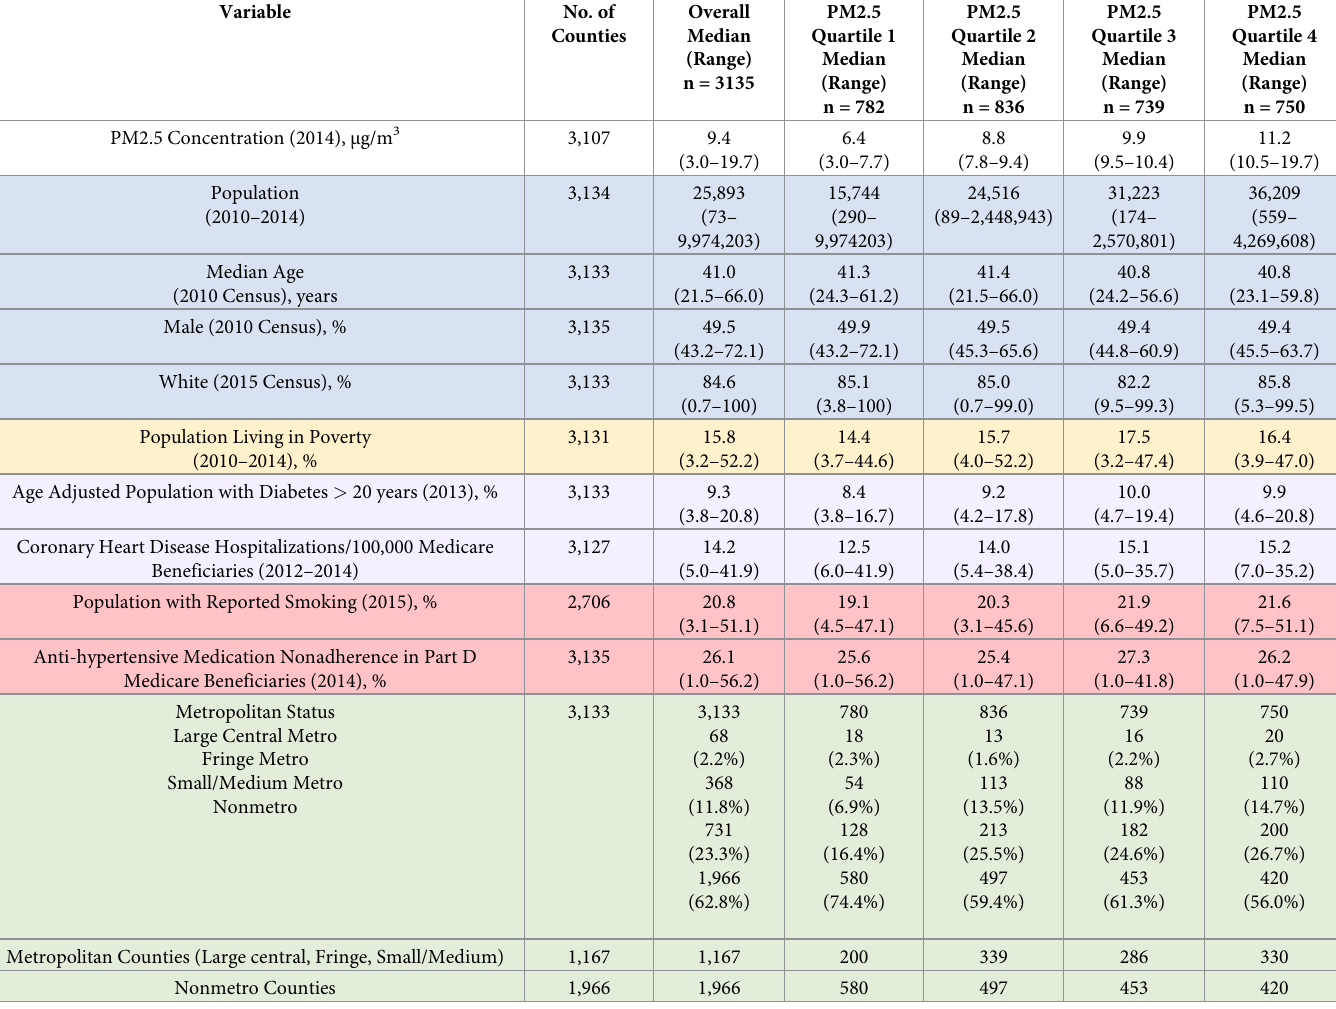
Table 1. Descriptive statistics of county PM 2.5 concentration levels and